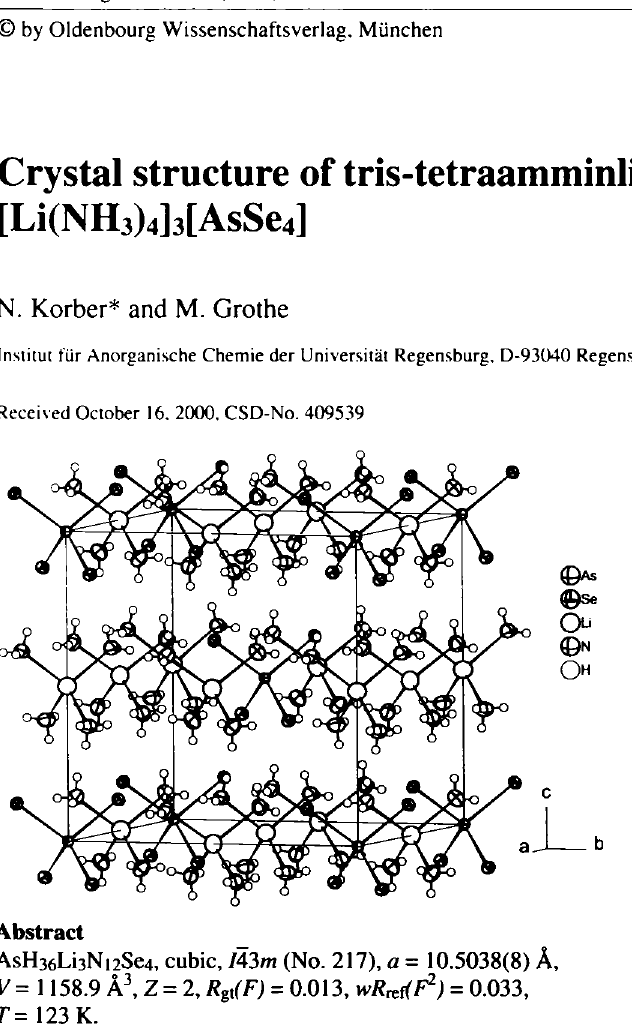
Table 1. Data collection and handling.